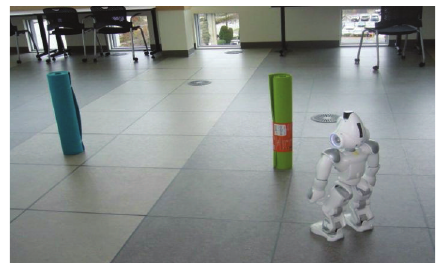
Figure 6: The scenario of the